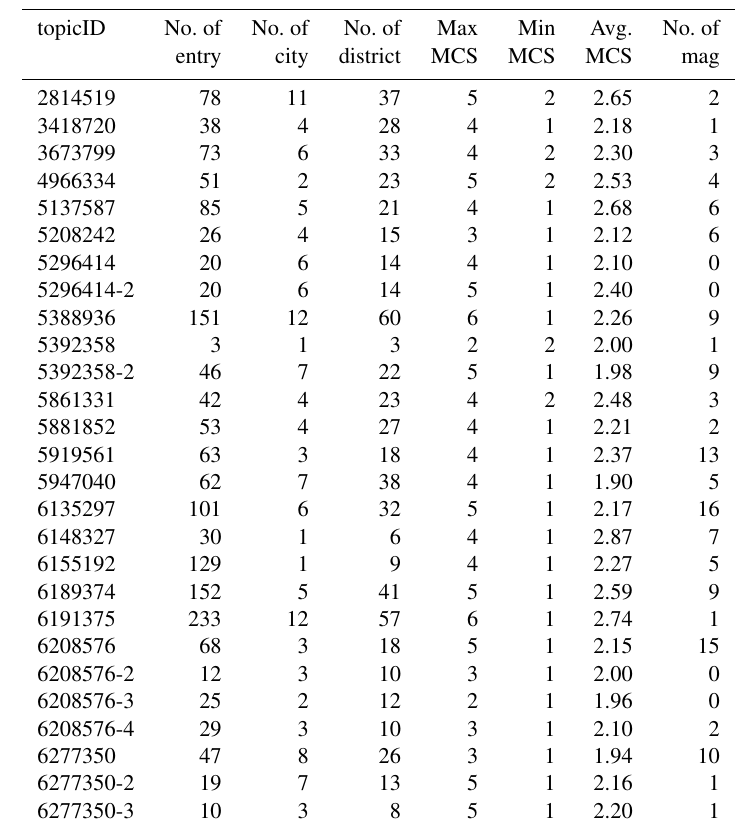
Table 2. Extracted information from entries of each topicID. The numbers of the entry, with the city and district information along with the Mercalli–Cancani–Sieberg (MCS) scale value, are shown. The unique numbers of the cities and the districts of these cities are given, respectively. The maximum MCS, minimum MCS, and average MCS of these entries, together with the entries with magnitude guesses, regardless of location information, are also shown.